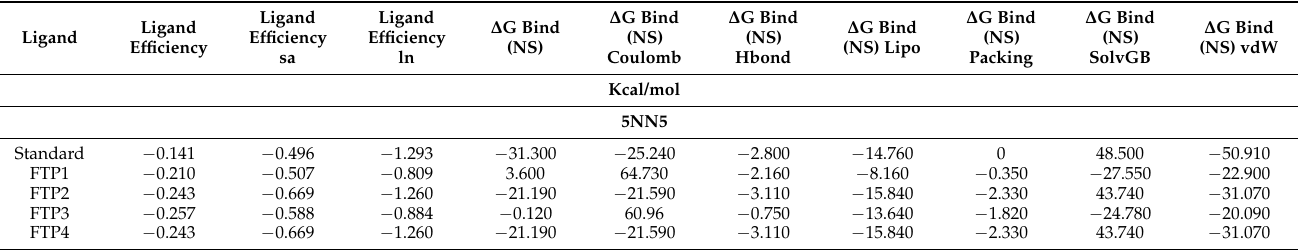
Table 5. Prime MM-GBSA calculations of polyphenolic compounds of Tradescantia pallida leaves’ extract.